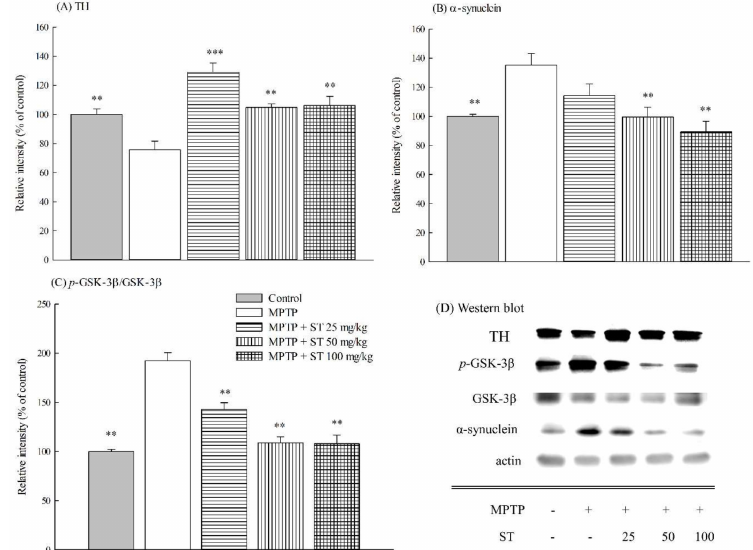
Figure 6. The effect of Sophora tomentosa extract (25 mg/kg, 50 mg/kg, and 100 mg/kg, po) on ( A ) the expression of tyrosine hydroxylase, ( B ) the expression of α -synuclein expression, ( C ) the ratio of p -GSK-3 β /GSK-3 β , and ( D ) protein was determined by immunoblot assay in an MPTP-induced PD mouse model. Data are expressed as mean ± SEM ( n = 5). ** p < 0.01, *** p < 0.001, compared with the MPTP group. Sophora tomentosa was administered for 15 consecutive days until the behavioral tests. MPTP (20 mg/kg, ip) were given two times at four-hour daily intervals for five days until